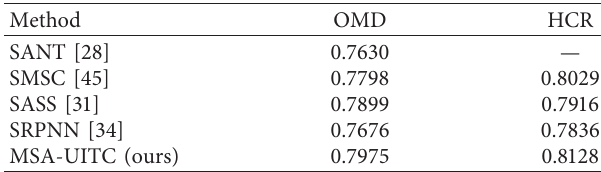
Figure 10: Performance comparison of attention mechanism on the HCR Table 2: Accuracy comparison with state-of-the-art methods.